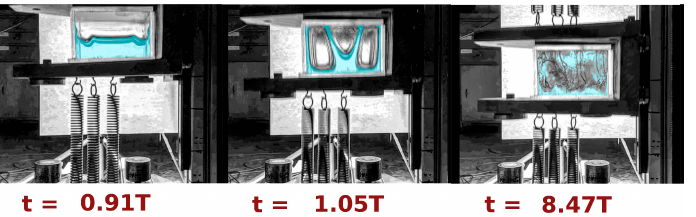
Figure 1. Experimental snapshots of the SDOF vertical sloshing water experiments carried out in [4] for 50% filling level.